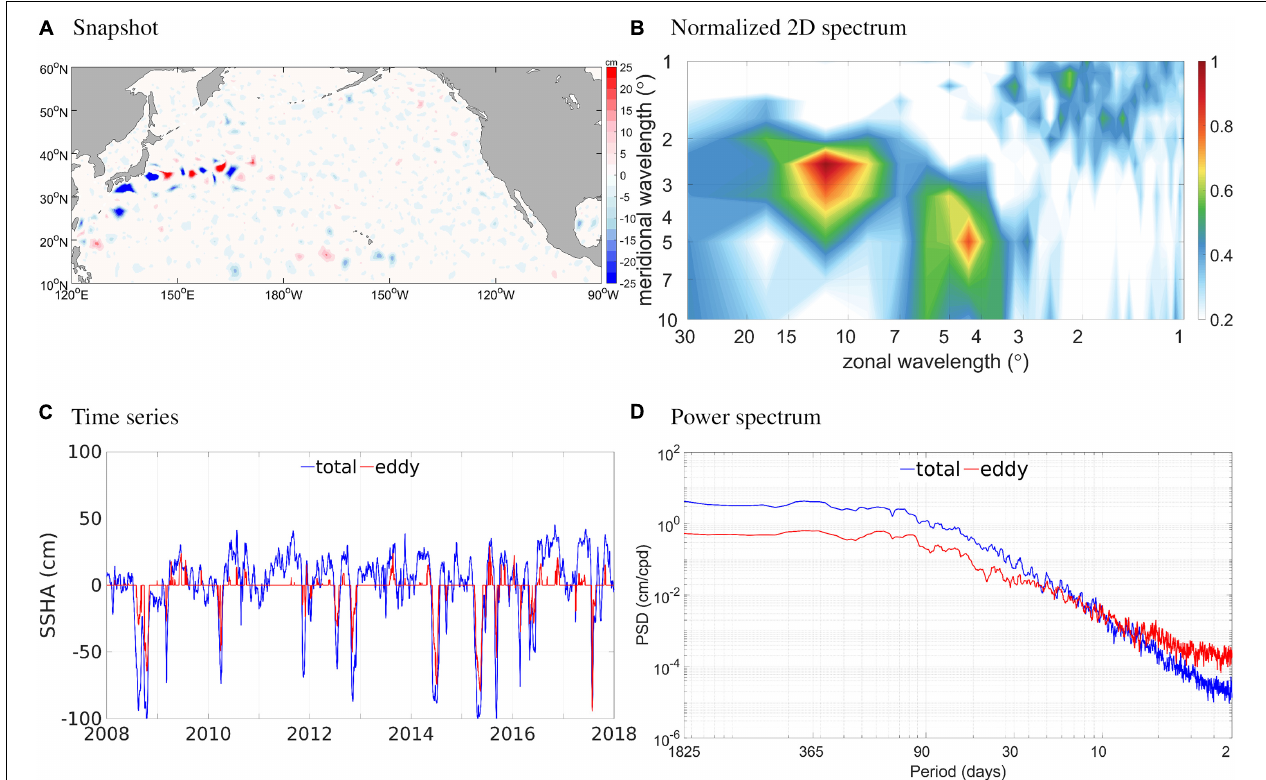
FIGURE 9 | (A) Snapshot of the reconstructed eddy-induced SSH (cm) field on January 1, 2008. (B) Normalized 2D power spectrum of reconstructed SSH in the Kuroshio Extension region (145 ◦ –180 ◦ E, 30 ◦ –40 ◦ N), averaged over the year 2008. (C) Time series of the original and reconstructed eddy-induced SSH (cm) at 150 ◦ E, 35 ◦ N. (D) Power spectral density of the original and reconstructed time series shown in (C)